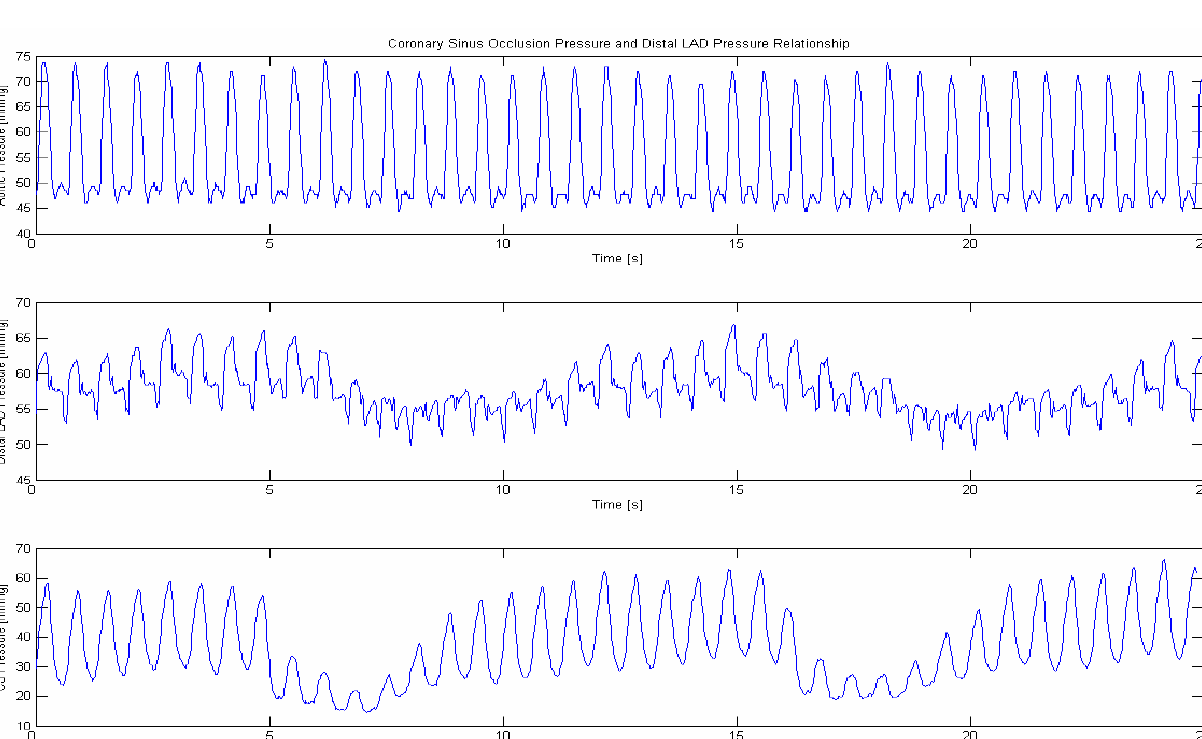
Figure 2. Coronary sinus pressure during occlusion of the LAD (occlusion of the left anterior descending coronary artery results in a large area deprived from nutritive blood flow and is the major cause for a subseuent myocardial infarction, therefore any means to increase flow into the area with a perfusion deficit salvages ischemic myocardium). Systolic pressure peaks produced by ventricular contraction retroperfuses blood into the deprived ischemic microcirculation and elevates the coronary artery pressure concomittantly until reaching a plateau after a few heart beats. Filling of the deprived ischemic microvasculature is seen by an elevation of the pressure in the occluded coronary artery. After pressure resumes by reopening the temporary occluded venous drainage, blood is squeezed out from zones dependent from occluded coronary arteries washing out toxic debris [27]. Mechanosensation of pressure peaks as well as distortion of cilia within cardiac veins by the force of the retroperfued blood and transduction via the cytosceleton of vascular cells initiate the process of ―embryonic recall‖. The putative element as we hypothesize is (1) Sensing of the elevated venous pressure in cardiac veins mimicking the equivalent mechanotransductory procedure during the first heartbeat in the embryo, re-opens a core control module for functional achievement initiating a molecular pathway similar to the developing heart. It corresponds to a desired reopening of a cascade of developmental events now deliberately initiated by biomechanical force using principles of normal organogenesis by restarting the biophysical initiation leading to re-establishment of dormant developmental molecular pathways similar to the initiation of the first heart beats in the primordial heart tube; (2) Re-establishment of monitoring the biophysical process with its molecular consequences of this core control module is the central dogma of the ―embryonic recall